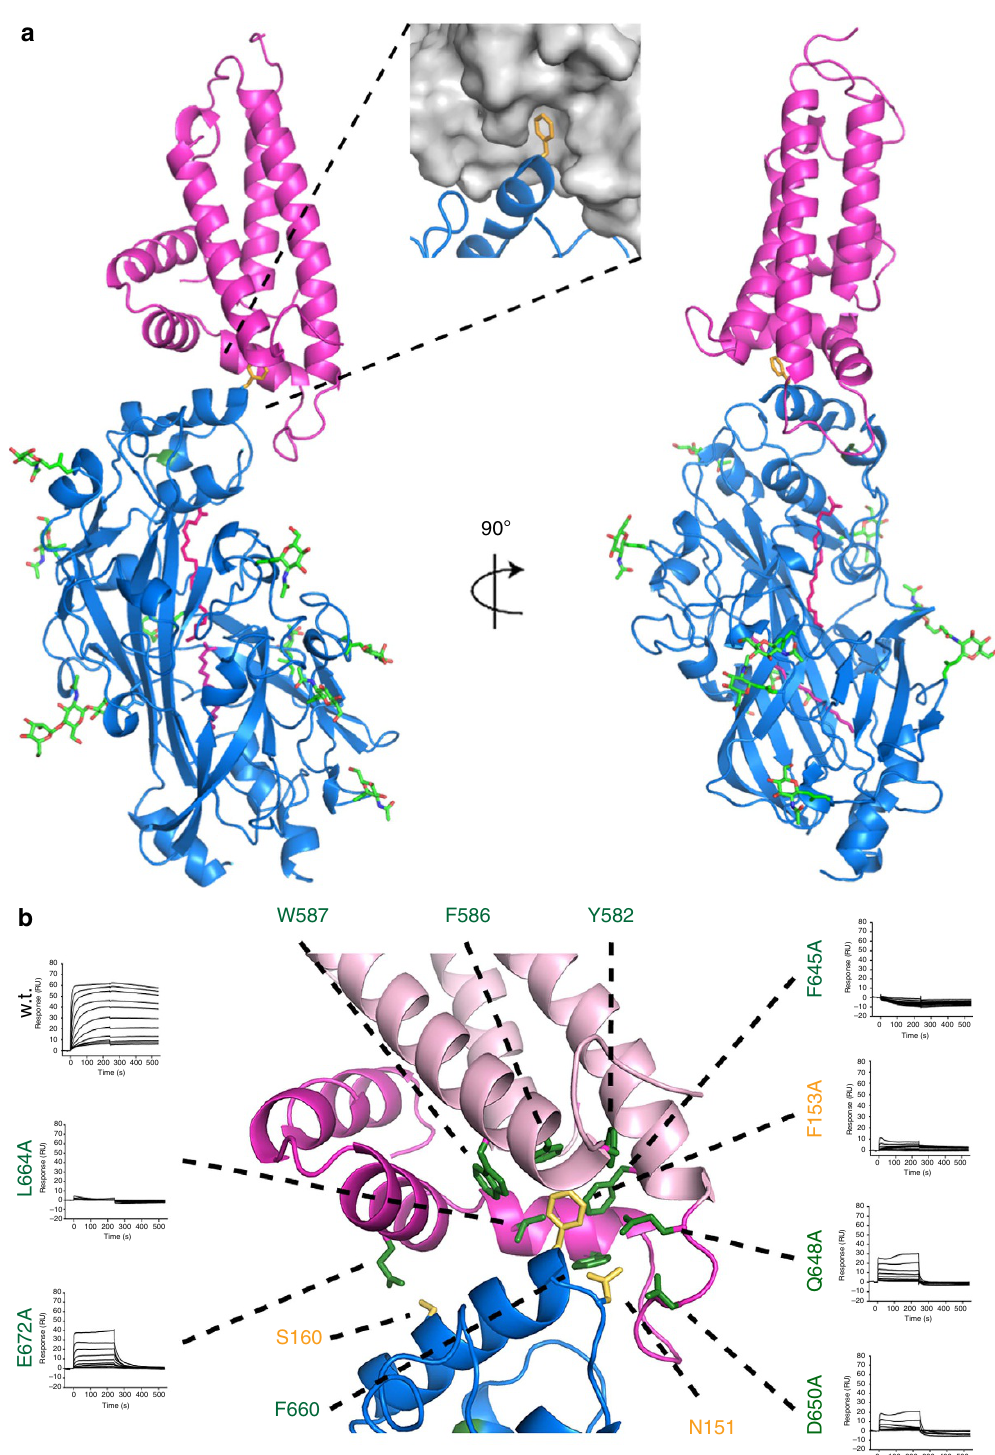
Figure 2 | The structural basis for CD36 binding by PfEMP1 proteins. ( a ) The structure of the complex of CD36 (blue) with the CIDR a 2.8 domain of the MCvar1 PfEMP1 protein (pink). N -linked glycans are shown in green. The inset shows a surface representation of the CIDR a domain with CD36 as a blue cartoon and F153 of CD36 in orange. ( b ) A close-up view of the interface between CD36 and the CIDR a domain with the key interacting residues labelled. The three-core a -helices of the CIDR a domain ( a 1, a 2 and a 6) are coloured in light pink while the insert ( a 3- a 5) is dark pink. Also shown is the effect of mutagenesis of key interacting residues as determined by surface plasmon resonance. The most critical interactions are mediated by F153 of CD36, which fits into a hydrophobic pocket lined by residues including F645 and L664 of the CIDR a We next produced a sequence logo for all members of these containing residues 673-683 was divergent in the CIDR a 3.1 domain subclasses (Fig. 4b,c). The majority of the domain subclass. As found before in the DBL and CIDR domains, the sequences could be aligned into a single logo. However, the loop majority of conserved residues were cysteines or aromatics 14,44 .